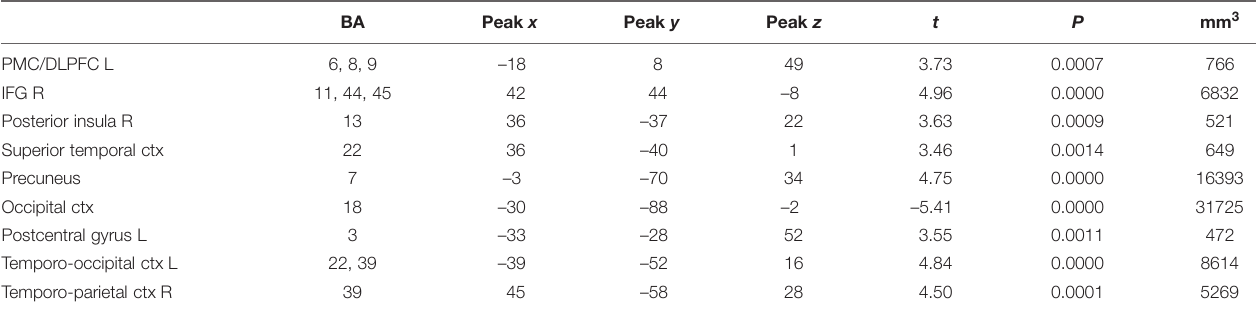
FIGURE 2 | Brain activation with color coded maps and time courses with signal changes according to a random effects analysis (p < 0.001) of the evaluation (eval.) and rating period, comparing high healthiness against low healthiness: (A) left dorsolateral prefrontal cortex (DLPFC), (B) precuneus, (C) visual cortex. In the 3D visualizations, red, blue, and green axes indicate the coordinate system. In the 2D coronal slice, the region with statistical significant activation of which the time course is derived is marked with the white crosshair. In the time course diagrams on the left side, the first vertical violet bars after the y-axis correspond to the activations during the first volume of the evaluation period. The second vertical violet bars correspond to the activations during the first volume of the rating period. TABLE 2 | Contrast evaluation period of healthy vs. non-healthy food photographs in the whole brain